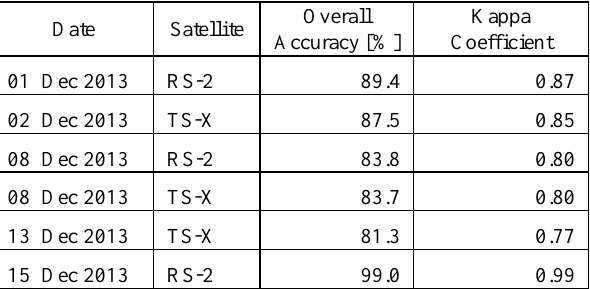
Table 2. Overall accuracy and kappa coefficient values for classified data. Abbreviations: RS-2 for RADARSAT-2 and TS- X for TerraSAR-X For all images, the best results (the highest user’s and producer’s accuracies) were obtained for the consolidated ice (CI) class. For other classes, three main problems were observed during classification. The first is related to skim ice (SI) and open water (OW). It occurred using the RADARSAT-2 data from 01.12.13 and TerraSAR-X data from 02.12.13. The skim ice surface is smooth and does not contain air bubbles, resulting in low backscattering similar to that of open